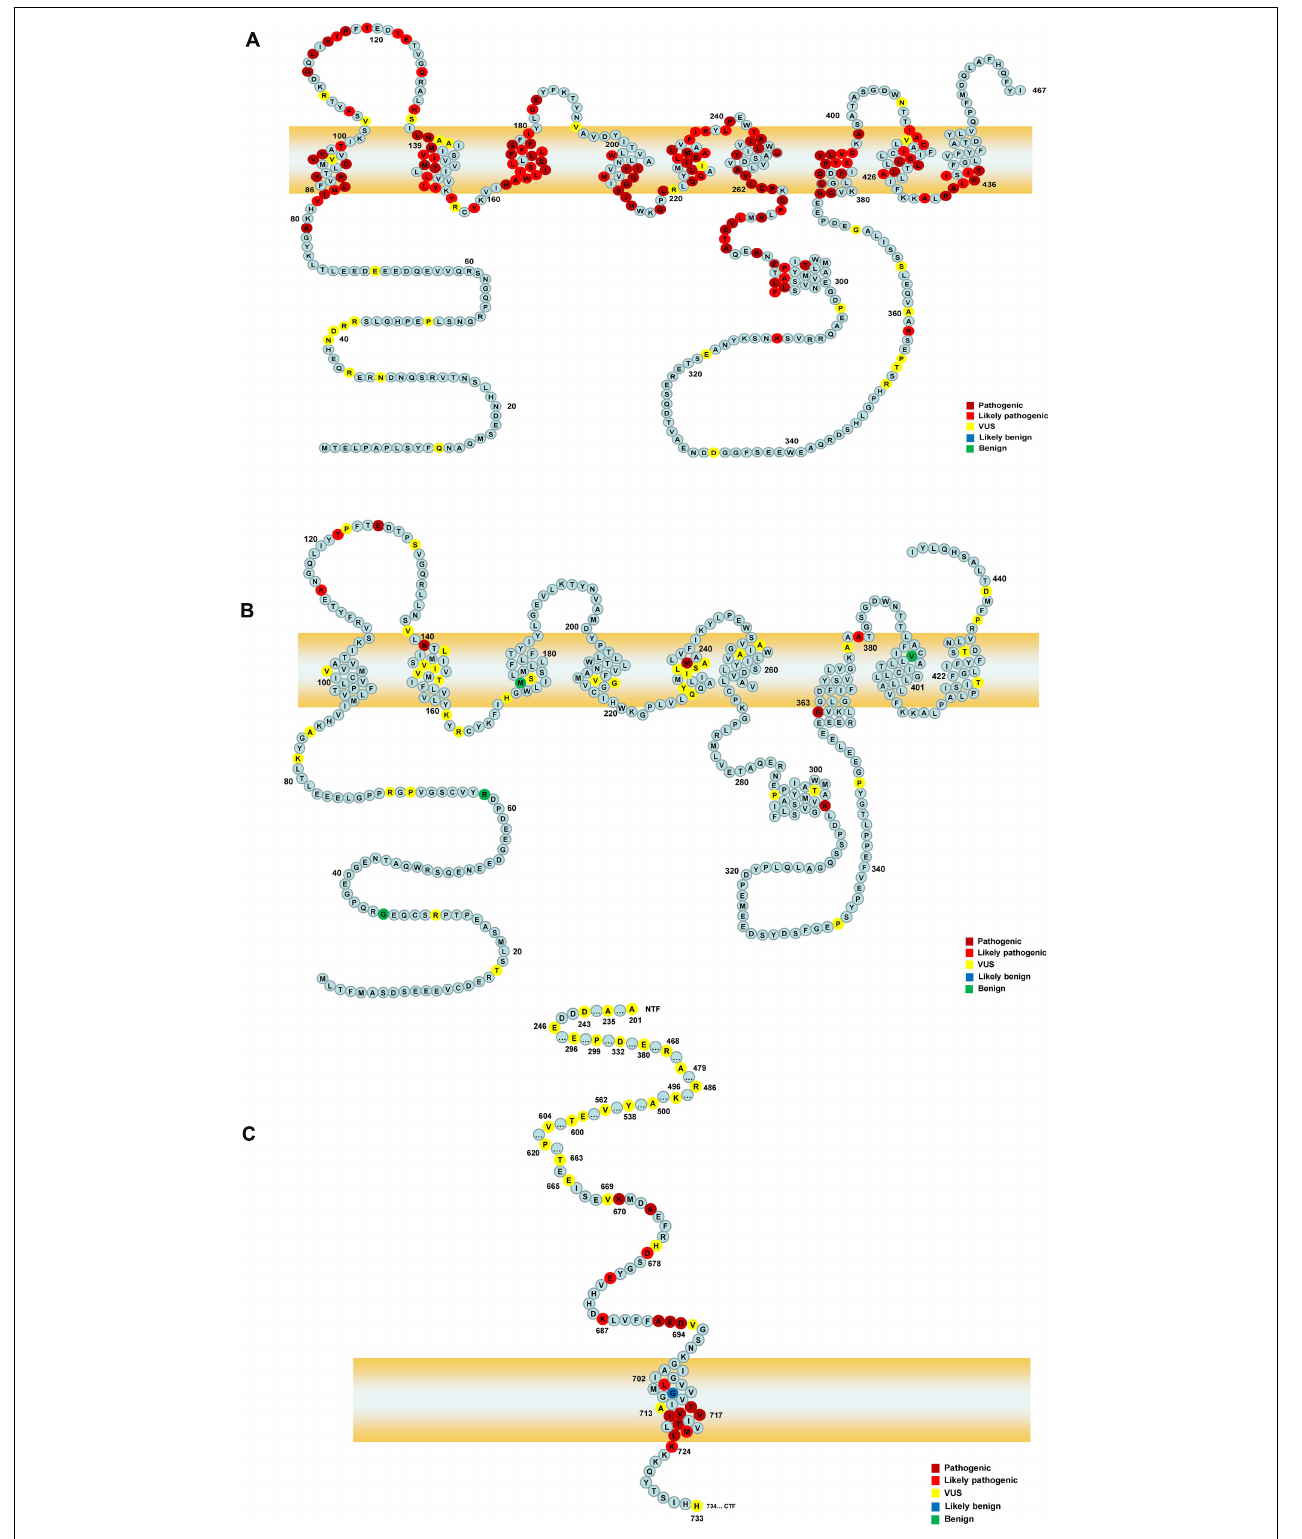
FIGURE 1 | The schematic of PSEN1, PSEN2, and APP proteins. Panels (A,B) represent the full-length amino acid sequence of PSEN1 and PSEN2, respectively. Panel (C) shows a part of the amino acid sequence of APP. Each circle with colors represents the likelihood of pathogenicity. Crimson circles: Pathogenic variants; Red circles: Likely pathogenic variants; Yellow circles: VUS variants; Blue circles: Likely benign circles; Green circles: Benign variants.